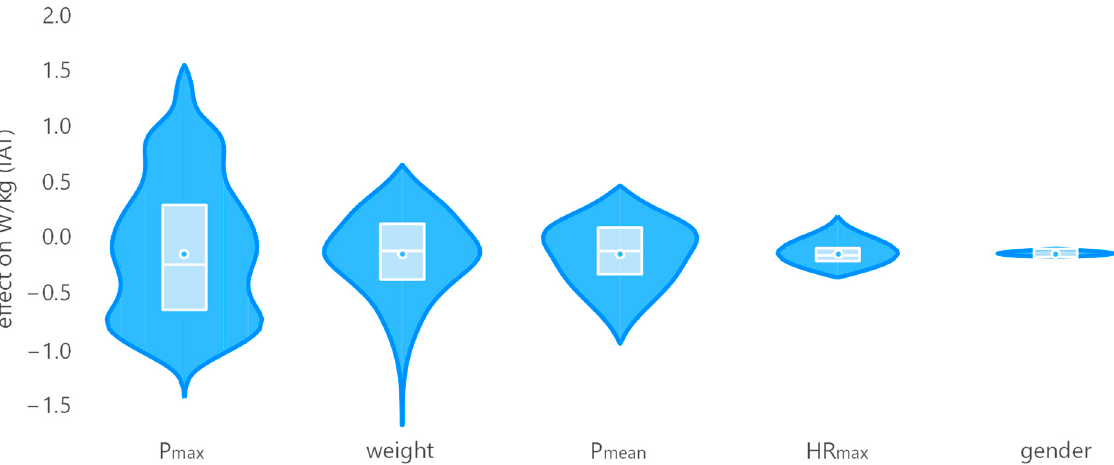
Figure 4. Effect plot for individual input parameters on W/kg(IAT) with parameter values normalized to a mean of zero for better comparison.